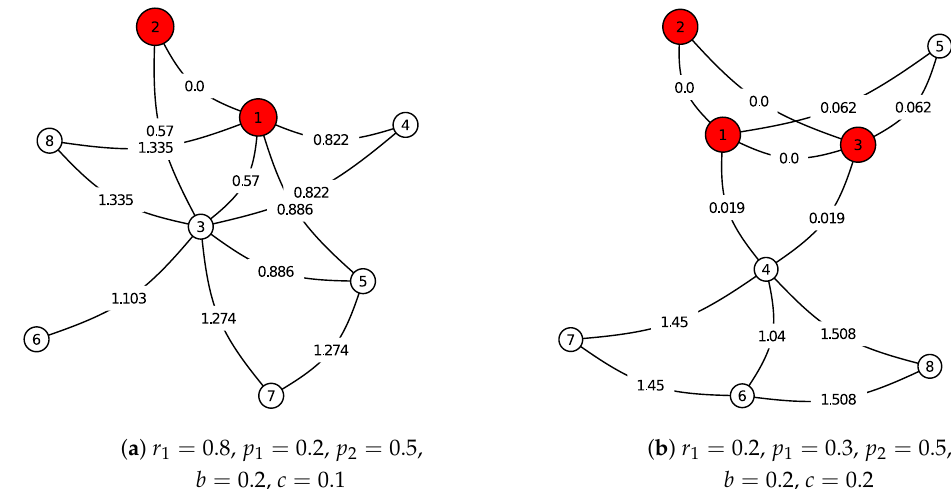
Figure 2. Examples of the graph evolution model with two different parameter